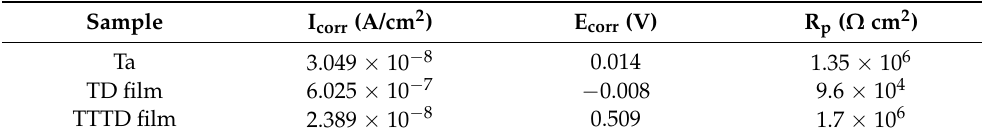
Table 3. Corrosion current density and corrosion potential of substrate, TD and TTTD films in weak alkaline